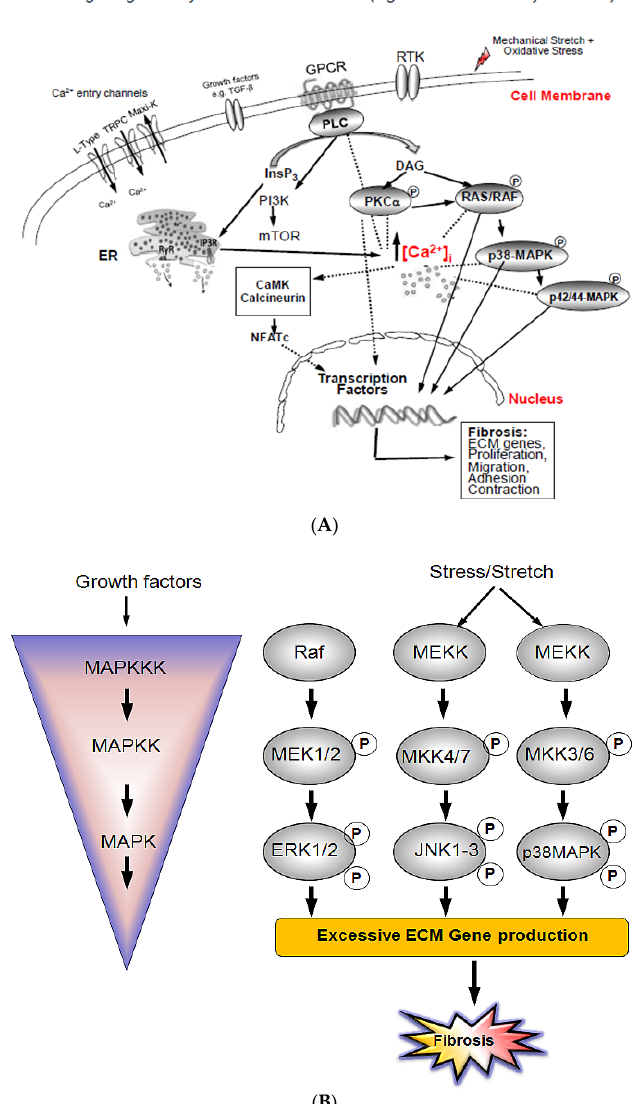
Figure 1. Fibrosis related intracellular Ca 2+ signaling pathways. ( A ). Schematic mechanism of key pro-fibrotic extracellular matrix (ECM) gene transcription regulation involving different signaling pathways. Including calcineurin/NFATc, PKC α , p 38-MAPK, and p 42/44-MAPK in lamina cribrosa (LC) cells. TGF- β , oxidative stress, and/or cell membrane stretch stimuli provoke [Ca 2+ ] i move- ments from Ca 2+ entry (through TRPC and L-type Ca 2+ channels) and extrusion of Ca2 + from Endo- plasmic Reticulum (ER), Ryanodine Receptor (RYR), and inositol triphosphate Receptor (IP3R,). [Ca 2+ ] i rise activates calmodulin, which in turn activates calcineurin. Activated calcineurin induces